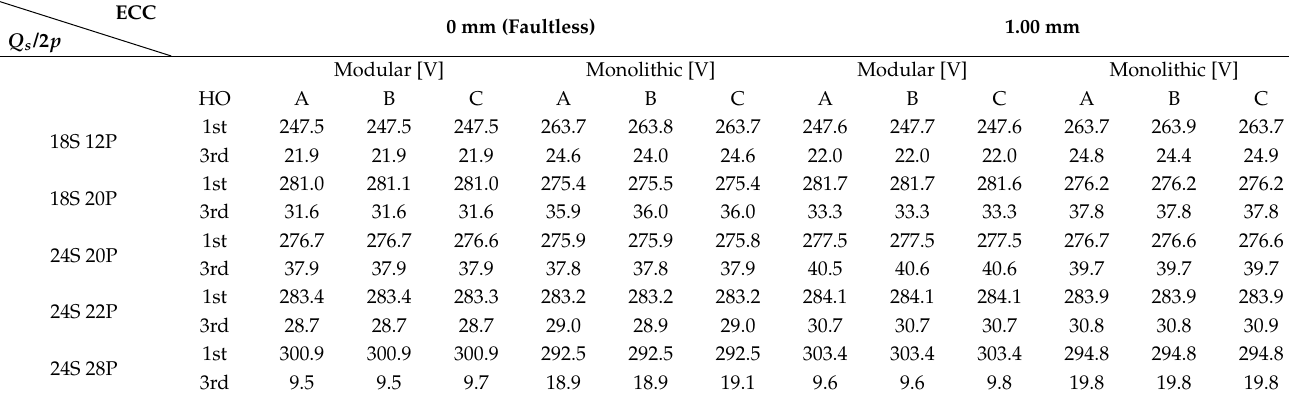
Table 14. Fundamental component and third-order harmonic of back-emf for different PMSM and MPMSM slot/pole combinations in the presence of